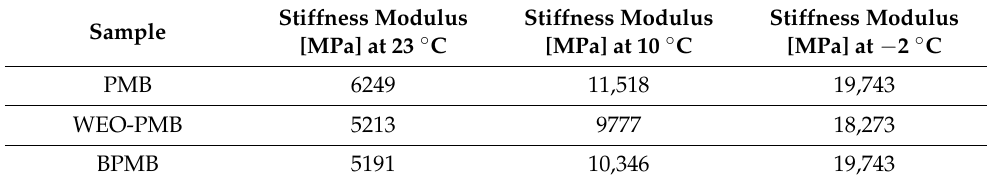
Table 3. Average stiffness moduli of the PMB, WEO-PMB and BPMB